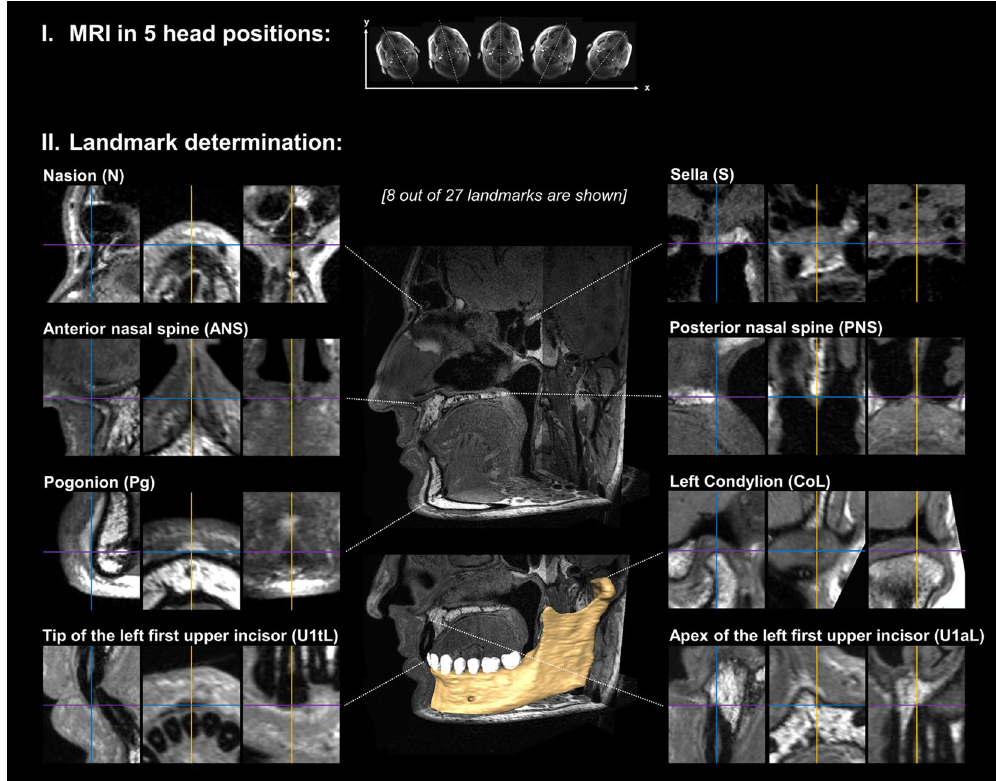
Figure 3. Acquisition of MR images and consecutive landmark determination in vivo . I Each volunteer received high-resolution MRI at 3 Tesla in 5 head positions differing in their degree of head rotation. As an example, head positions of volunteer #2 are illustrated by the original axial localizer images. II For each MRI scan, a total of 27 cephalometric landmarks were determined on multiplanar reconstructions (MPR). In this figure, MPR of 8 exemplary landmarks are shown for illustration. The volume segmentation of the left mandible was performed using Amira software (Version 6.4.0, Thermo Fisher Scientific, MA, USA). The full set of cephalometric landmarks is defined and illustrated in Fig.